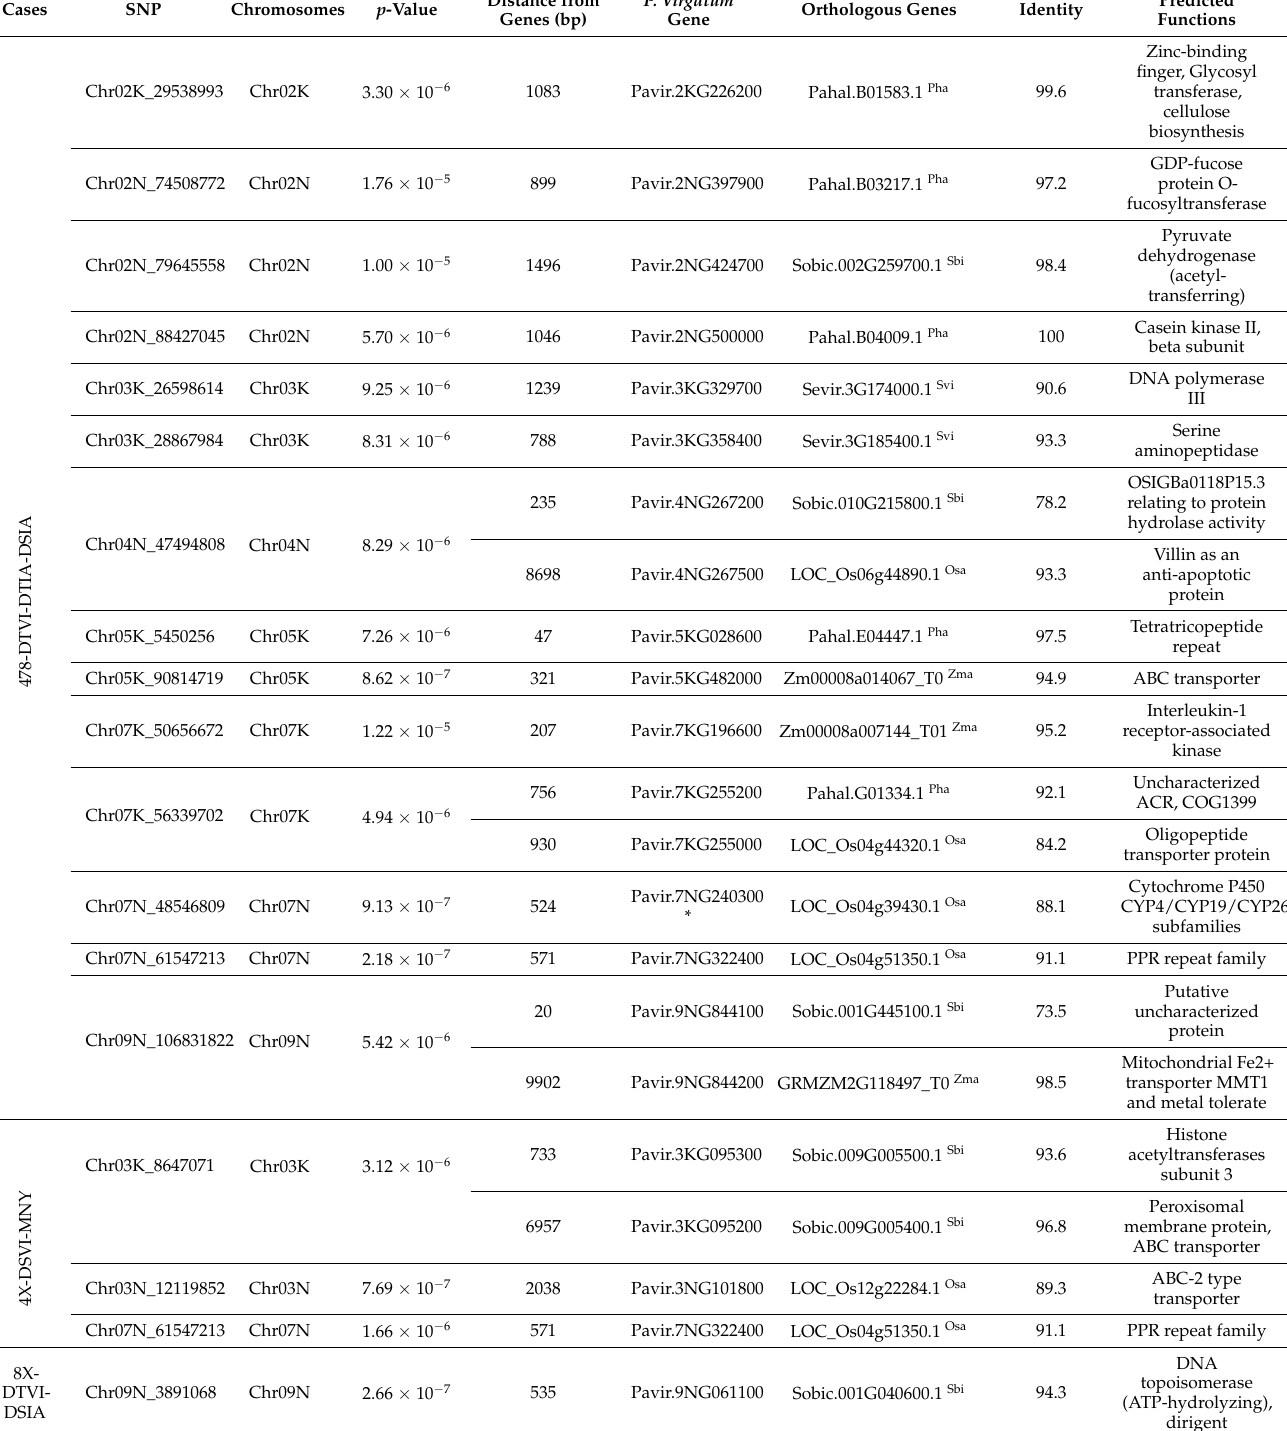
Table 2. Markers significantly associated with resistance to Bipolaris leaf spot in five GWAS